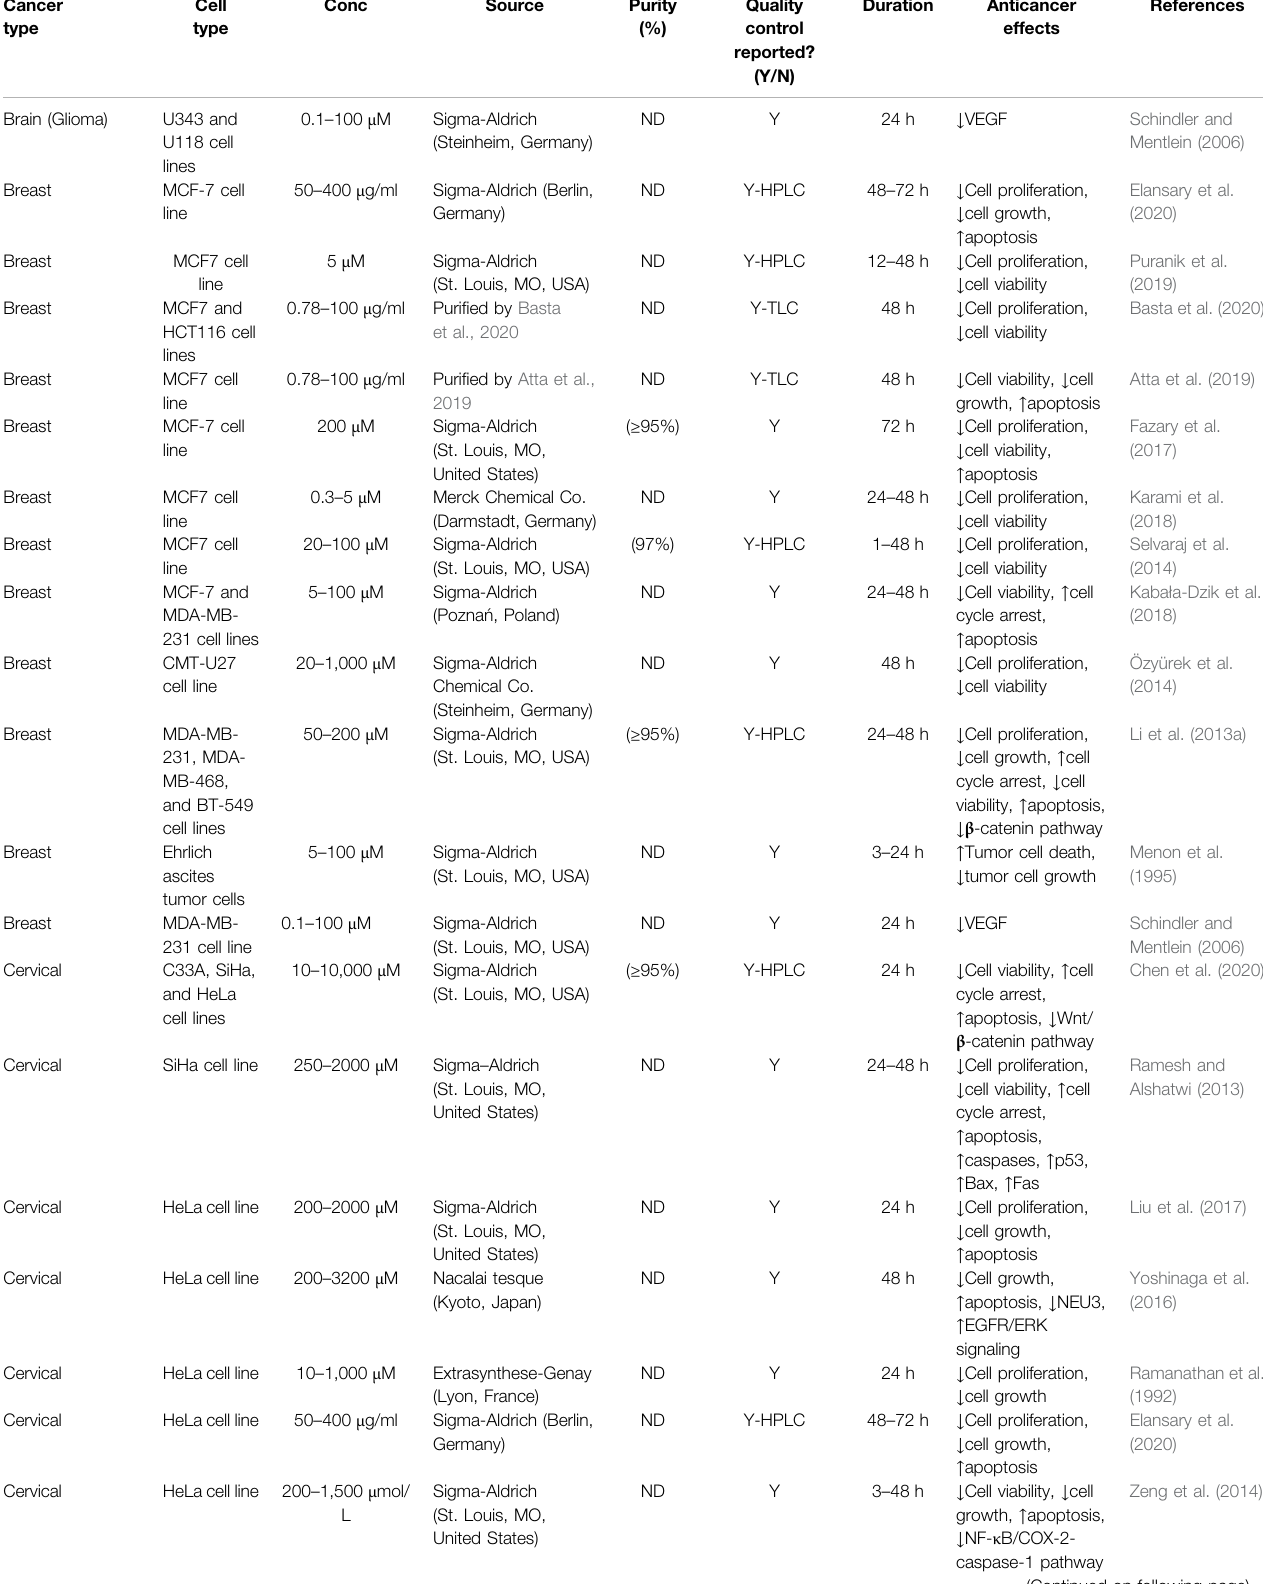
TABLE 3 | ( Continued ) Potential anticancer effects and related mechanisms of action of naringin based on in vitro